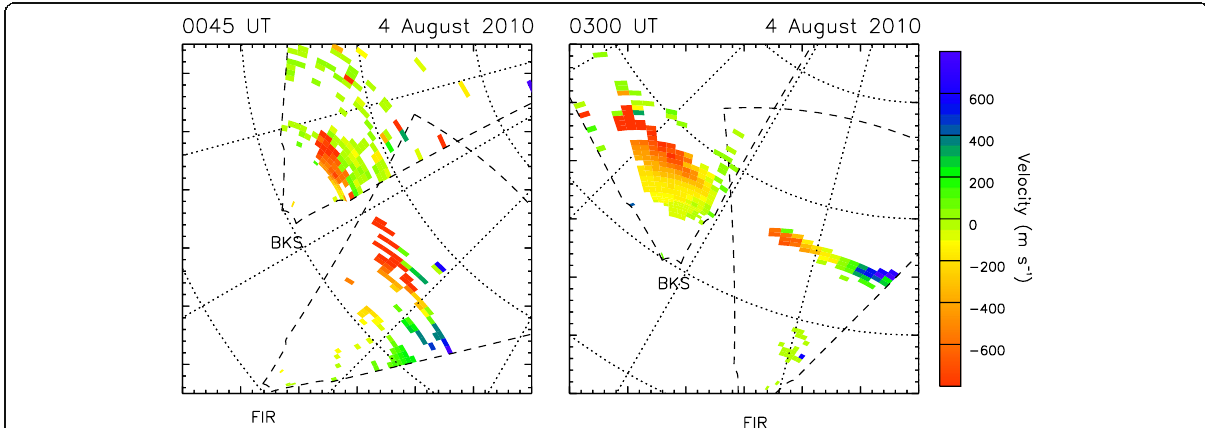
Fig. 13 Conjugate radar observations of a SAPS flow channel for two different periods showing excellent agreement in the latitude of the channel between BKS and FIR. Reproduced from Fig. 6 of Grocott et al.